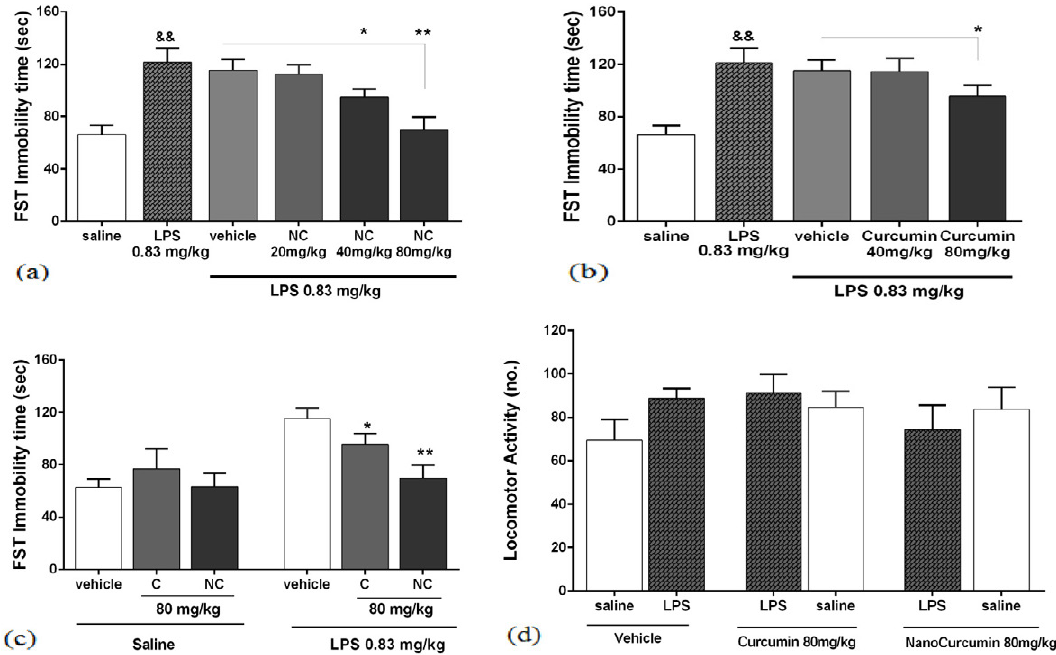
Fig. 1. Effect of curcumin (C) and nanocurcumin (NC) 40 and 80 mg/kg, i.p. on duration of immobility (sec.) in forced-swimming test (FST) on lipopolysaccharide (LPS)-treated mice. && P<0.01 significantly different from saline group. * P<0.05 and ** P<0.01 significantly different from LPS + vehicle (olive oil) group (n= 6-8).